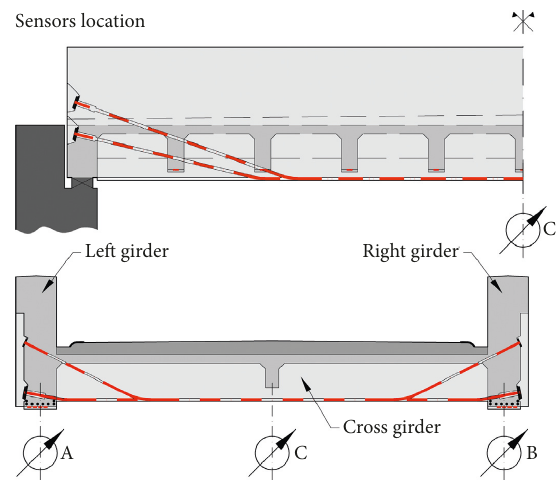
Figure 18: Location and description of deflection sensors in the longitudinal and transverse directions on the U-shaped bridge built in 1932 [21] for the purpose of the static load test.